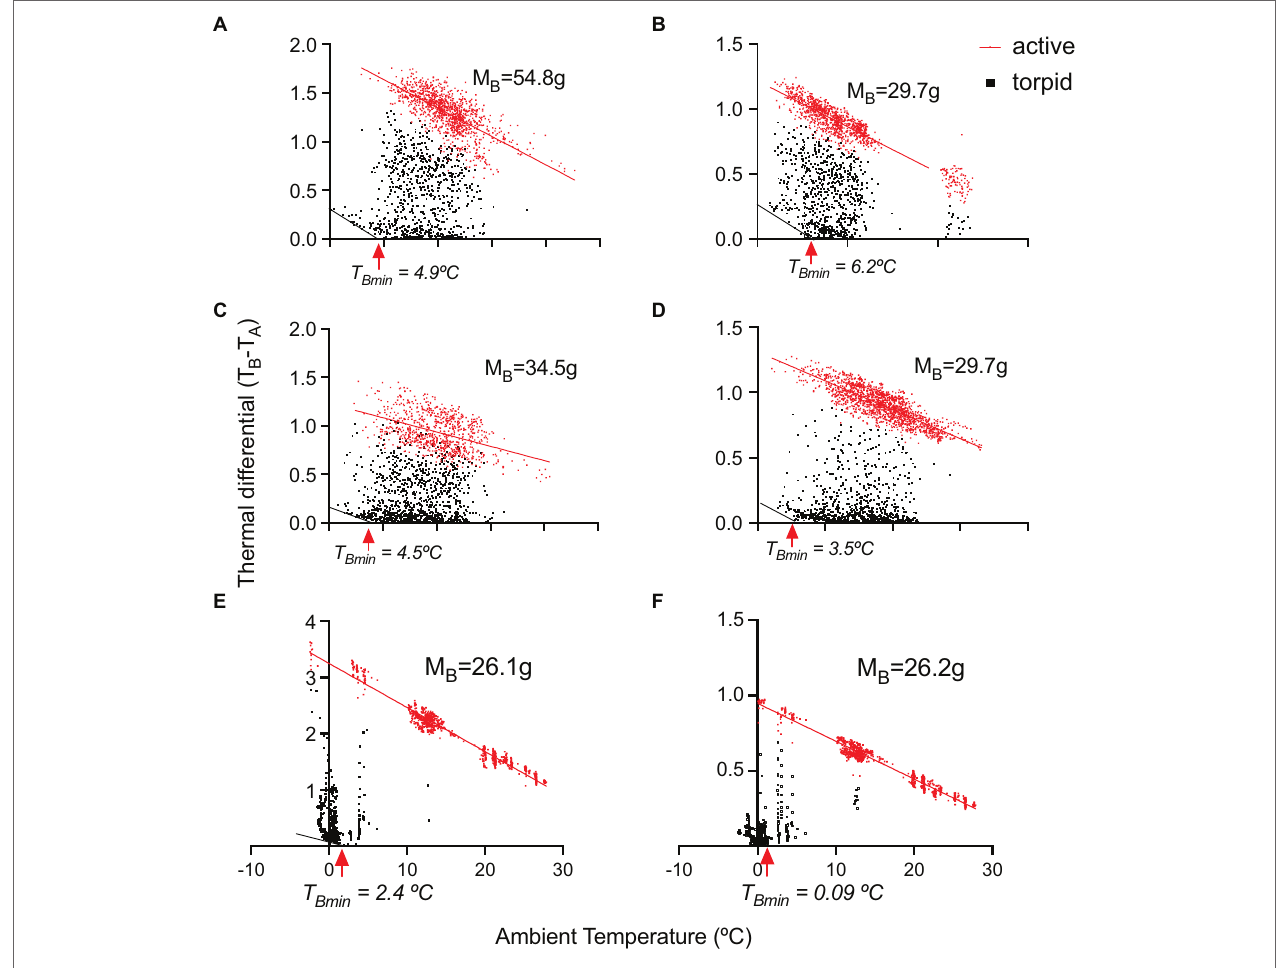
FIGURE 6 | Thermal differential ( T B − T A ) in six monitos. The first four animals (A–D) are from the outdoor experiment, and the last two (E,F) were from the ramp experiment, showing torpor at sub-freezing T A s (see the details in Figure 8 ). T Bmin denotes the temperature at which animals start